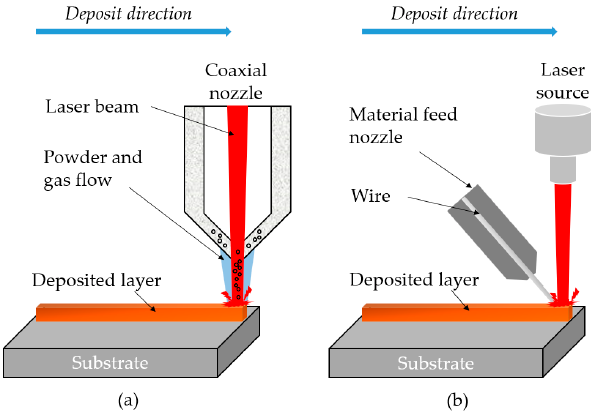
Figure 2. Schematic diagram of the DED and welding processes using ( a ) a coaxial nozzle and ( b ) a material feed nozzle.